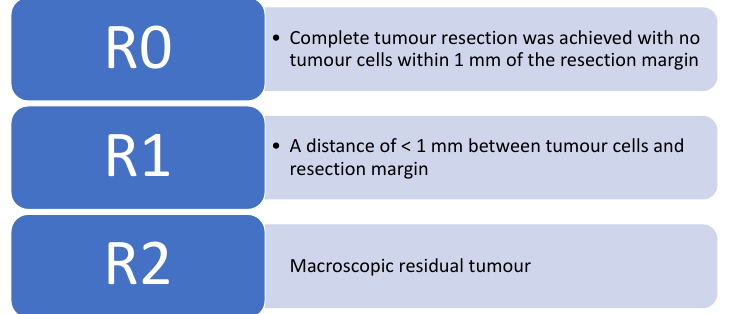
Figure 1. The United Kingdom Royal College of Pathologists has stated the current R classification [7].